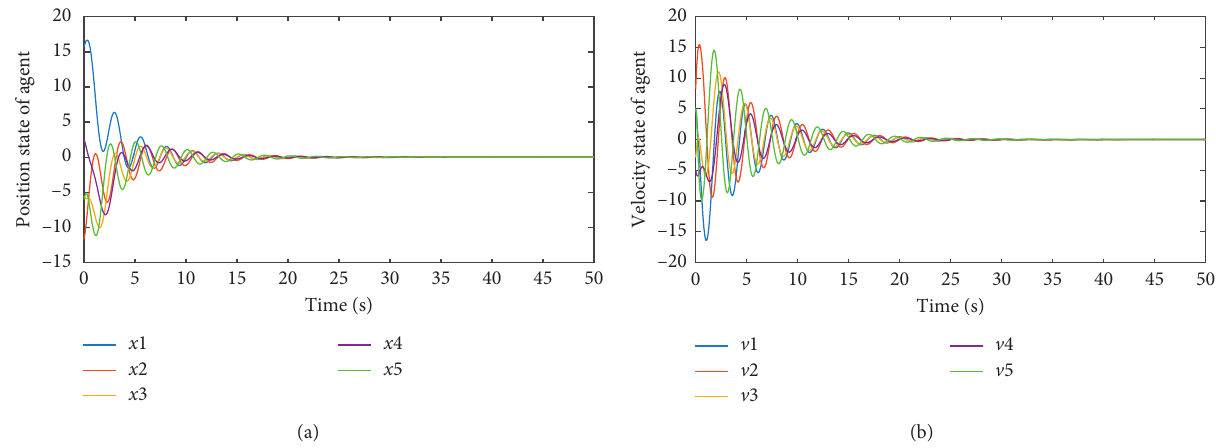
Figure 4: Position and velocity states of agents on structurally unbalanced network in Figure